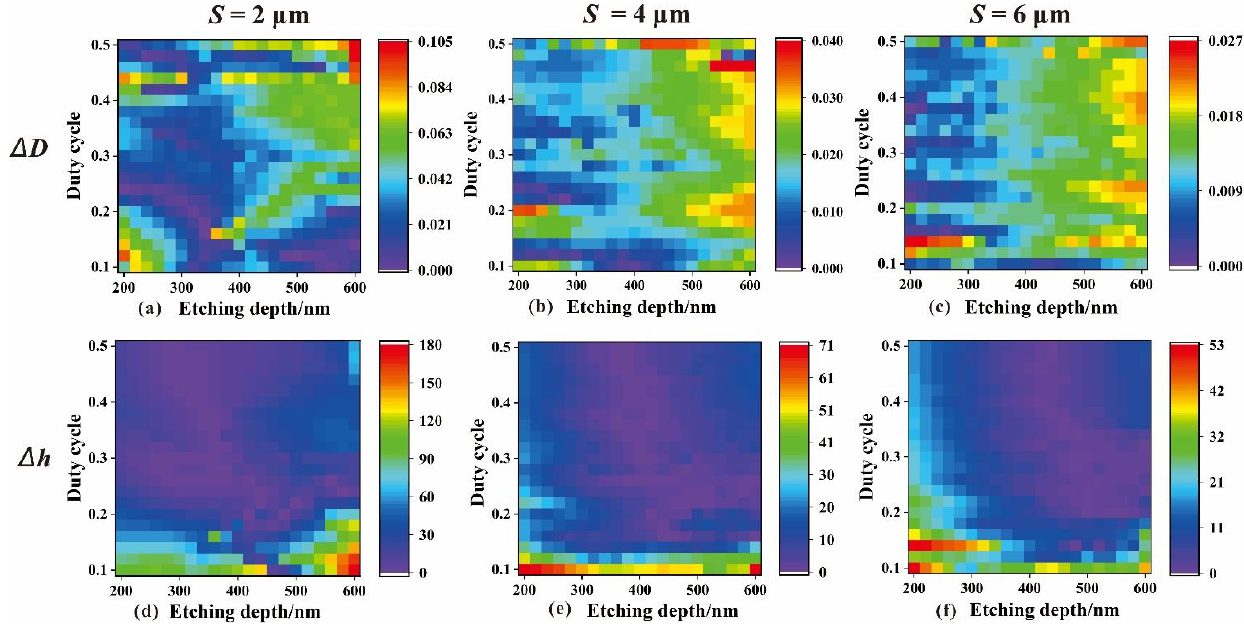
Figure 6. Reconstruction geometric errors for duty cycle D (0.1 – 0.5) and etching depth h (200 – 600 nm) with scalar approximation and rigorous calculations. ( a – c ) and ( d – f ) indicate the duty cycle errors Δ D and etching depth errors Δ h in reconstruction for gratings with periods of 2, 4, or 6 μm, respectively. The step was set to 0.2 for the duty cycle D 0 and 20 nm for the depth h 0 . The sampling of the search step was 0.001 for D and 1 nm for h in the rigorous simulation. The values of the color bars indicate the deviation in D and h (nm).